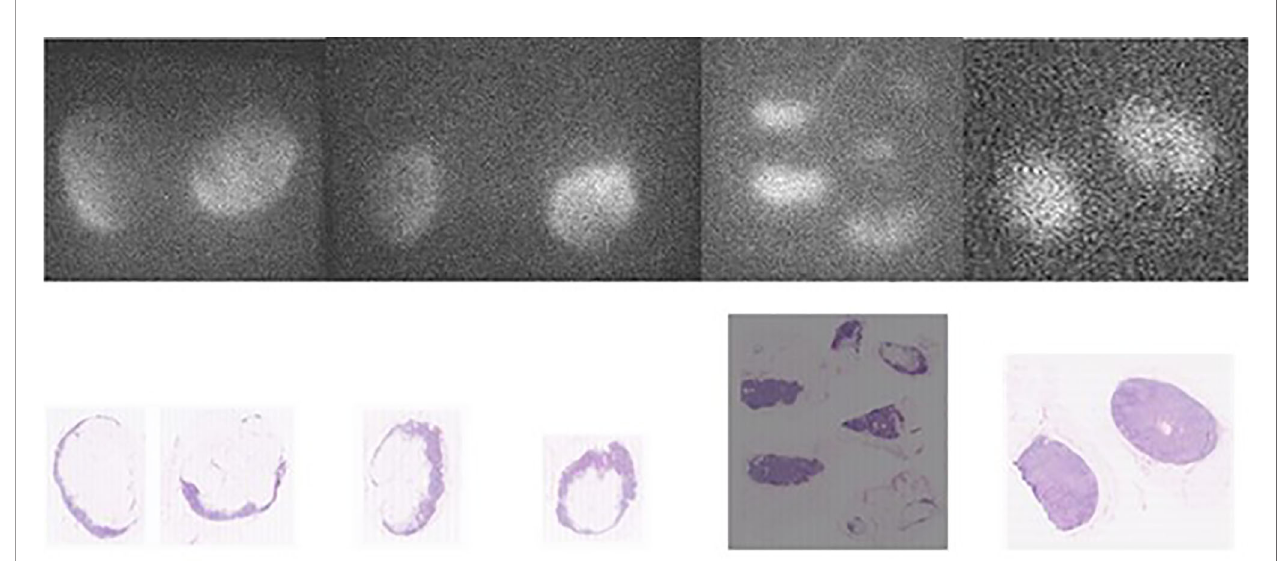
FIGURE 3 | Comparison between fl uorescence images of the lymph node embedded in paraf fi n (upper pictures) and the corresponding AP slices (lower pictures) obtained from pN- patients. From left to right, the fi rst three sets of pictures correspond to lymph nodes from patient n° 8 (of group 2) and the last right-sided set of pictures are lymph nodes from patient n° 9 (of group